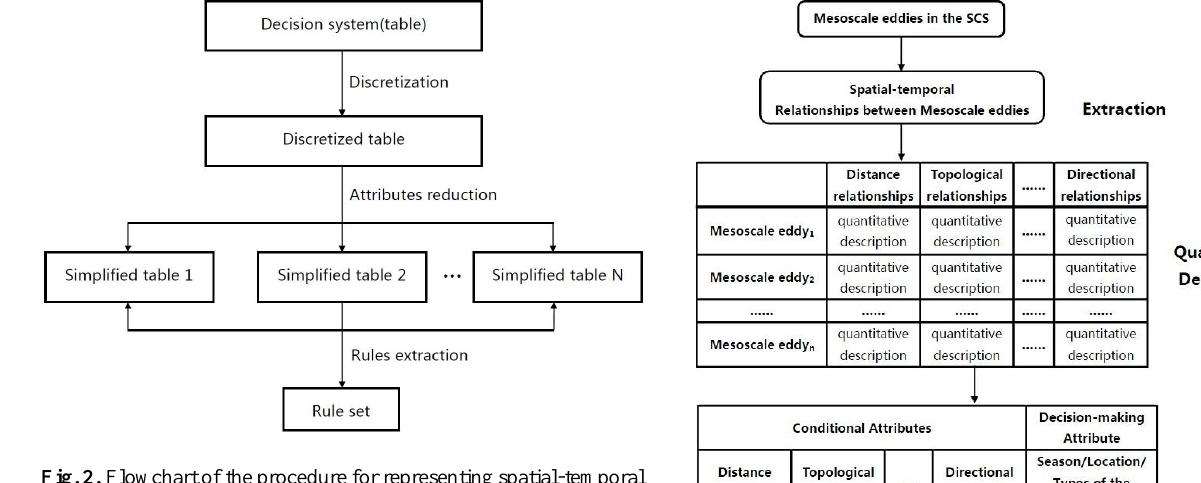
Fig. 2. Flowchart of the procedure for representing spatial-temporal relationships among mesoscale eddy states.